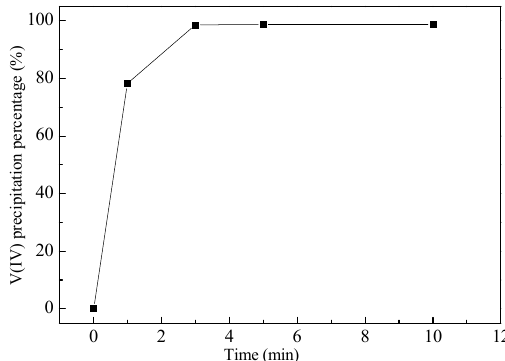
Figure 8. Effect of reaction time on the concentration of vanadium precipitate.